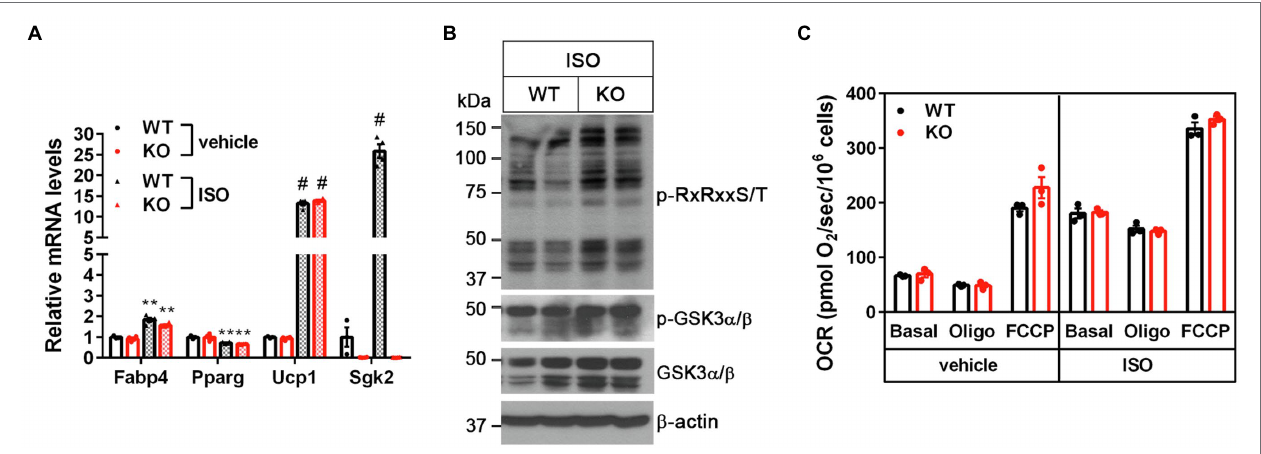
FIGURE 4 | Sgk2 ablation does not alter β AR-stimulated mitochondrial respiration in brown adipocytes. (A) No change in brown adipogenesis by Sgk2 ablation. Sgk2 +/+ (WT) and Sgk2 − / − (KO) brown preadipocytes were differentiated into brown adipocytes for 7 days and treated with or without isoproterenol for 4 h ( n = 3–4 per group). (B) Effect of Sgk2 ablation on downstream signaling in isoproterenol-stimulated brown adipocytes. (C) Effect of Sgk2 ablation on mitochondrial respiration in differentiated brown adipocytes (7 days) in the absence and presence of β AR stimulation. Oxygen consumption rates (OCR) were measured at baseline and after addition of oligomycin and FCCP ( n = 4 per group). All data are presented as the mean ± SEM. ** p < 0.01, # p < 0.0001 determined by Student’s t